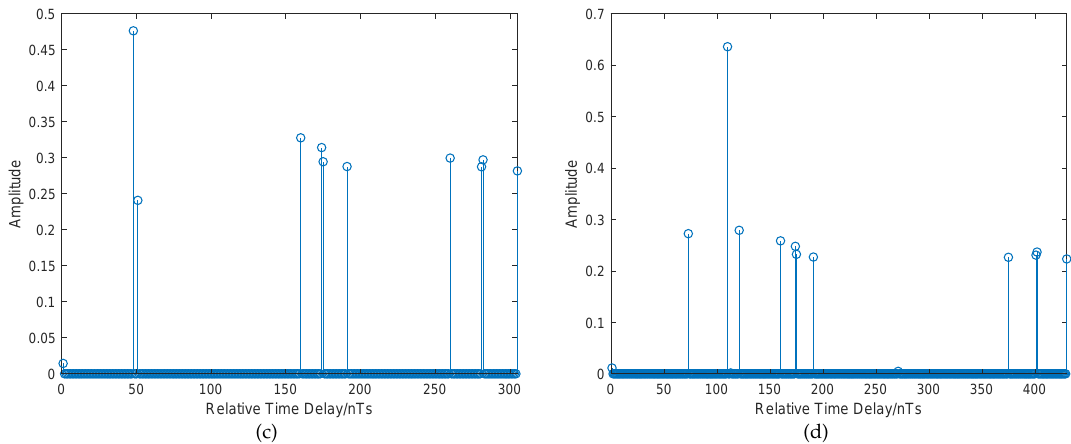
Figure 10. Normalized CIRs of channel with different sea bottom boundaries. Sea bottom boundaries of each figure: ( a ) rising bottom; ( b ) falling bottom; ( c ) protruding bottom; ( d ) sagged bottom.